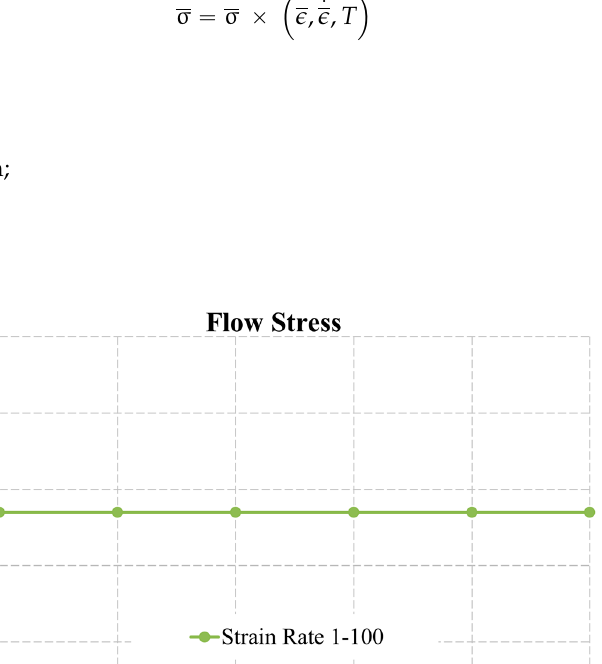
Figure 6. Material flow law.